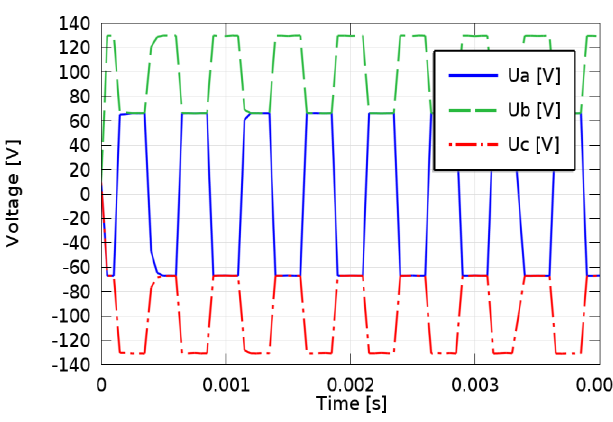
Fig. 14. The phase voltages on the stator windings in COMSOL. These voltages appear on the winding of the COMSOL motor model as the result of the inverter excitation waveform originated from the Simulink